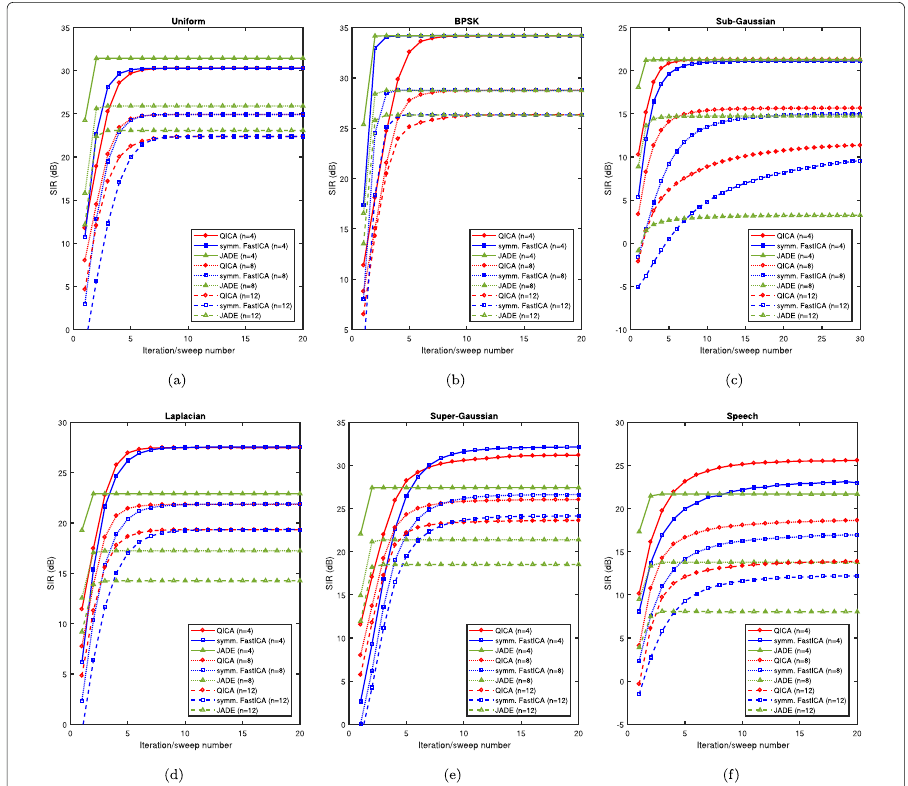
Fig. 5 Average SIR index as a function of sweep/iteration number, obtained using QICA (circles), symmetric FastICA (squares), and JADE algorithm (triangles) for various data distributions. a Uniform distribution. b BPSK signals. c Sub-Gaussian distribution. d Laplacian distribution. e Super-Gaussian distribution. f Speech distribution represented by randomly selected frames of the real speech